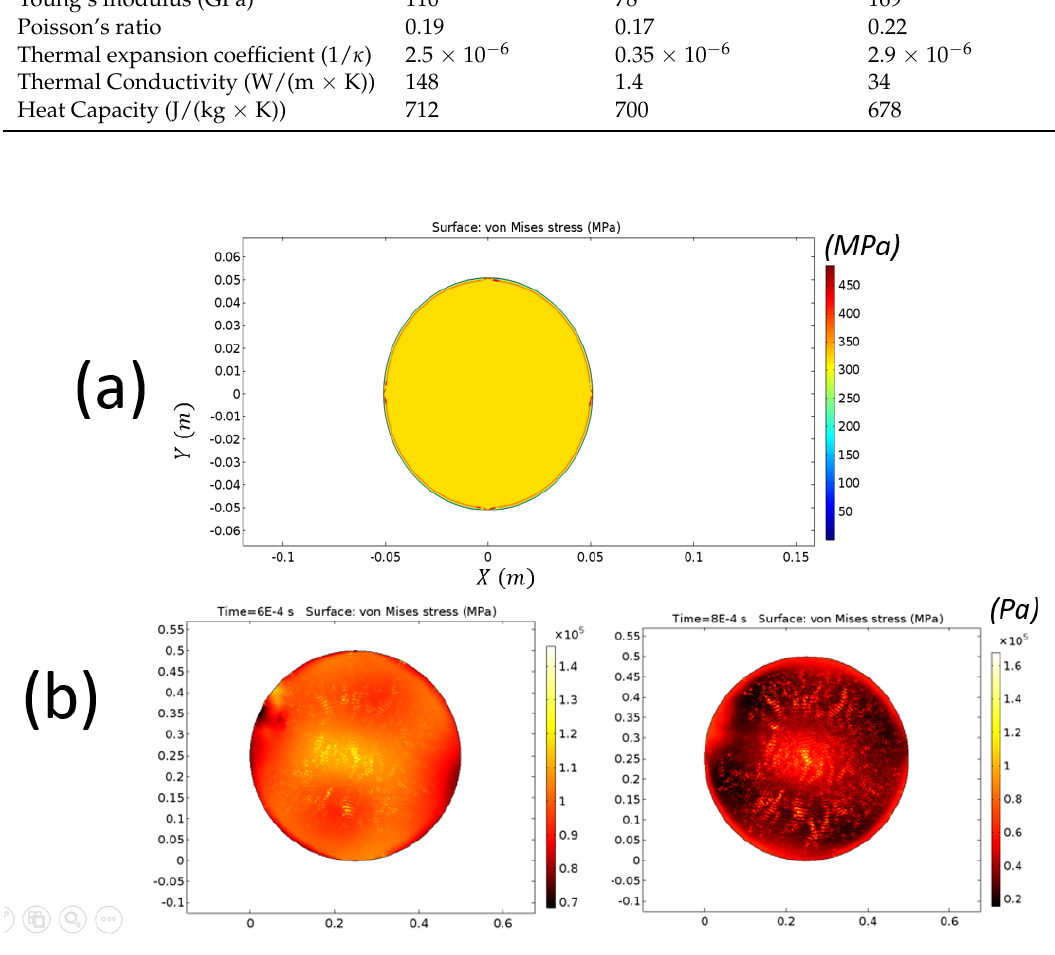
Figure 8. SDPs for the entire 10 cm (4 in) diameter wafer surface as obtained from COMSOL numerical simulation along a radial line for the SN device. ( a ) stationary solver; ( b ) time-dependent solution, after thermalization time of 60 ms (left) and 80 ms